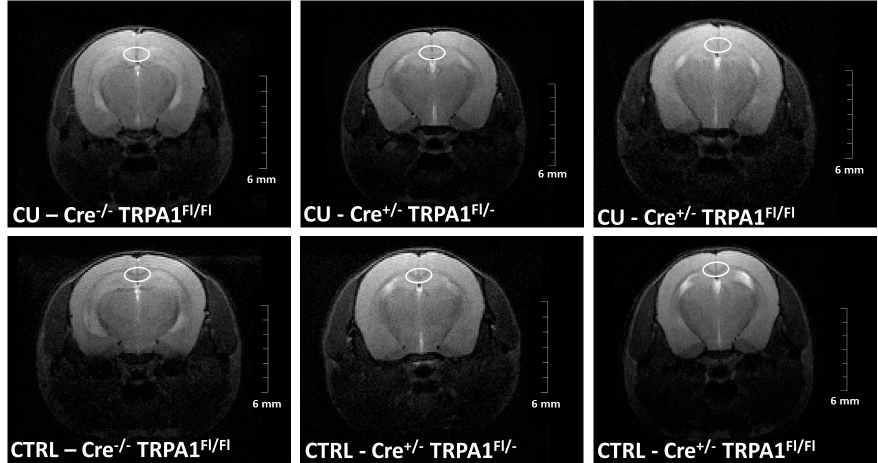
Figure 2. Representative MR images, constructed on fourth week. The medial corpus callosum is highlighted by a white ellipse.